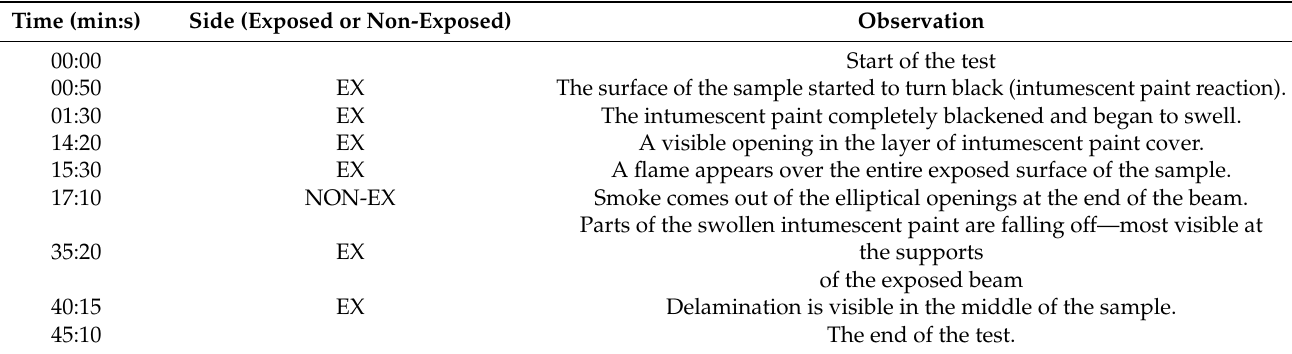
Table 6. Observations during fire testing—hollow beam with intumescent paint.